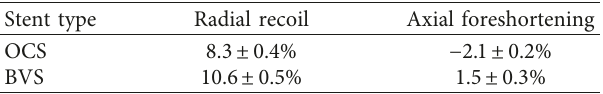
Table 4: Radial recoil and axial foreshortening of the OCS